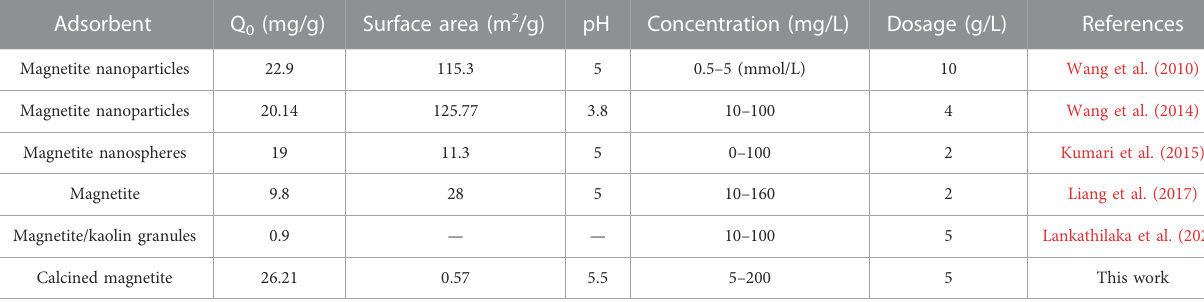
TABLE 3 Comparison of Pb (II) adsorption properties of magnetite in different references. Adsorbent